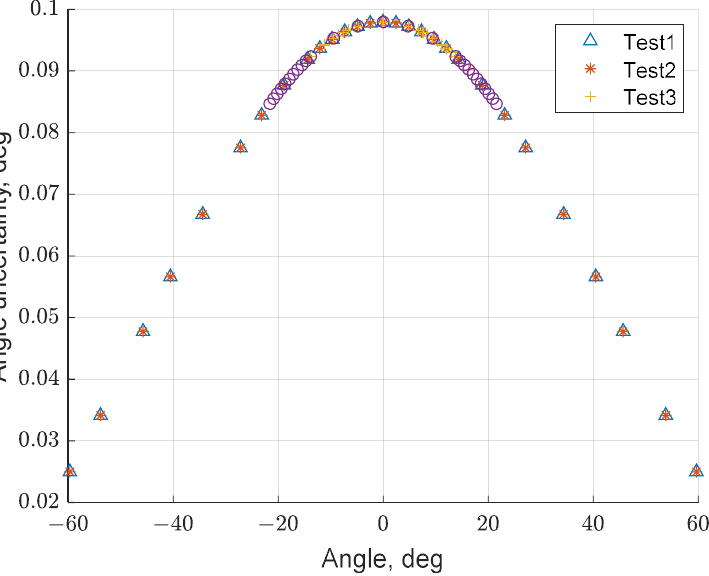
Figure 5. Uncertainty associated with angle measurement in function of the SQM rotation stage angle.